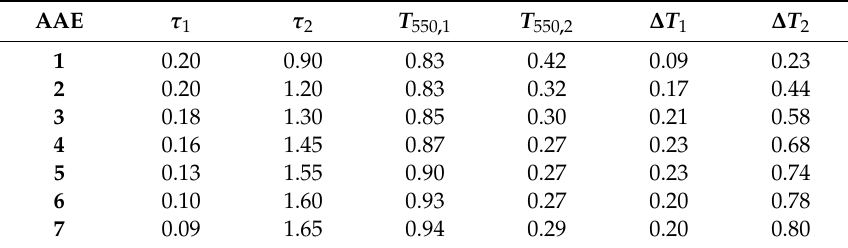
Table 2. Parameters of characteristic